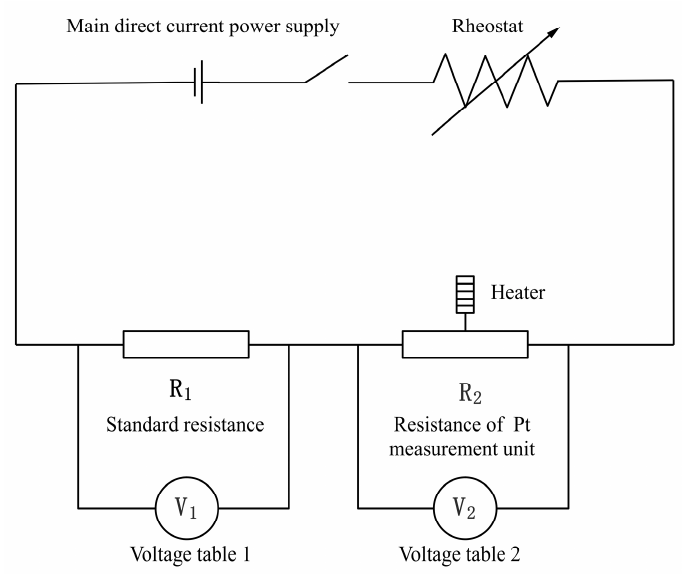
Figure 3. Constant temperature vacuum chamber. (1—sensor, 2—constant temperature heating plate, 3—electrode).